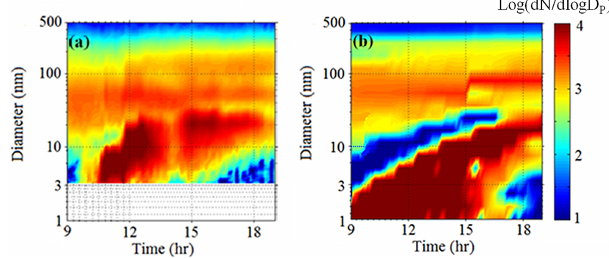
Figure 4. (a) Mass fraction of fresh particles and (b) mass fraction of SOA for the different volatility bins as a function of local time at Hyytiälä. Simulation includes bSOA aging and σ = 0.025Nm − 1 .